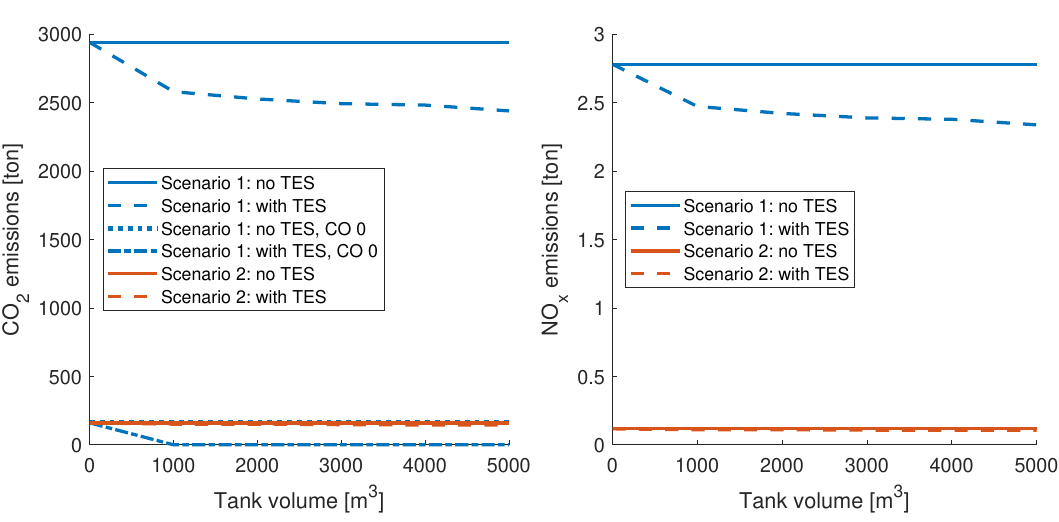
Figure 6. The reduction in CO 2 ( left ) and NO x ( right ) emissions as a function of tank size. For CO 2 emissions for Scenario 1, both the present situation with free quotas for CO (indicated as “CO 0”) and possible future Scenario with a nonzero emission factor are shown .